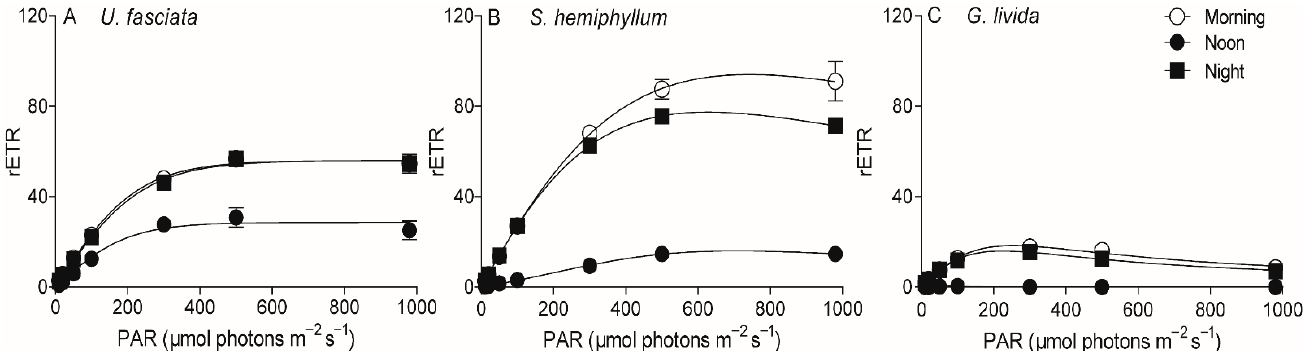
Figure 3. Relative electron transfer rate (rETR) of PS II versus light (µmol photons m − 2 s − 1 ) curves in the time periods of morning, noon and night for ( A ) U. fasciata , ( B ) S. hemiphyllum and ( C ) G. livida . Points show averages of measurements on three independent macroalga thalli, and error bars show the standard deviations ( n = 3), often within symbols.